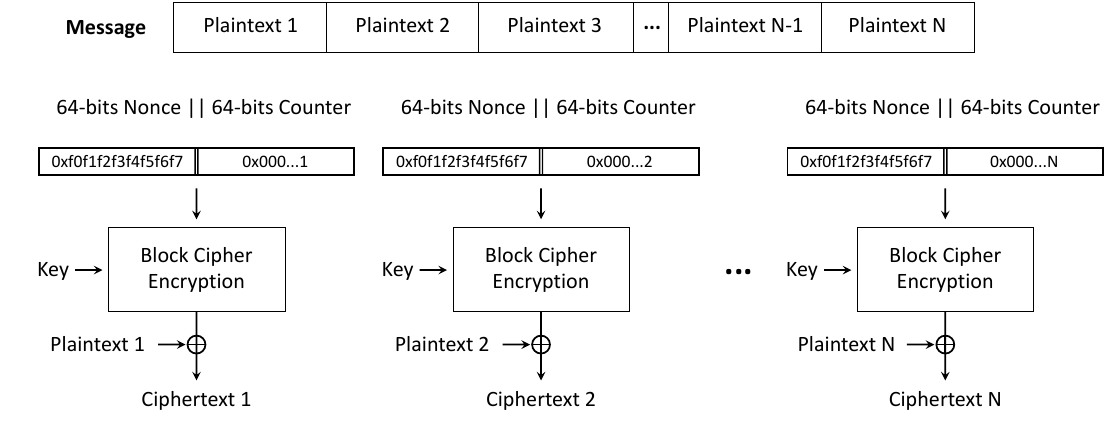
Figure 3. CTR operation mode